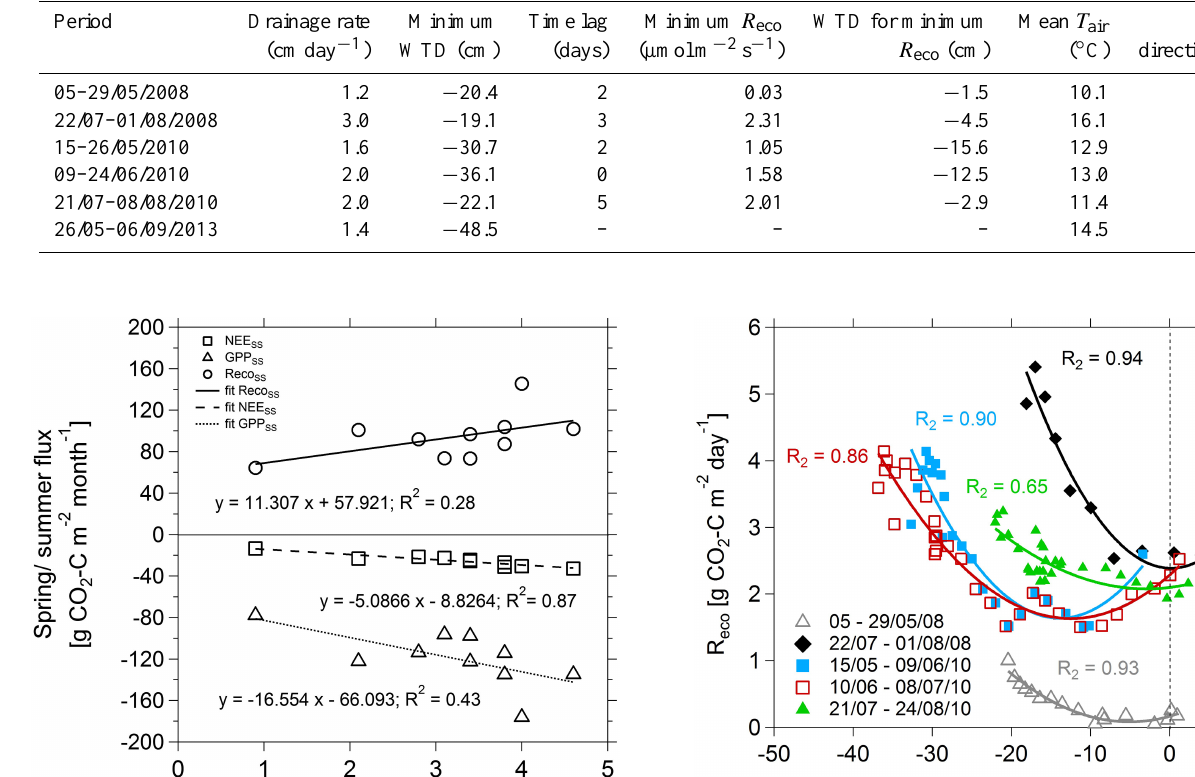
Table 2. Water table drainage rates and minimum water table depths (WTD) observed during the summer dry spells of 2008, 2010 and 2013. The time lag is the number of days elapsed between the start of the dry period and the onset of a response from the ecosystem respiration ( R eco ); the time lag was determined by optimising the polynomial fit between R eco and WTD. The minimum value of R eco for each dry spell and the water table depth corresponding to each minimum value of R eco were calculated using a second degree polynomial regression function between R eco and WTD. No parabolic relationship was observed in 2013 between R eco and WTD; for this reason, time lag, minimum R eco and WTD for minimum R eco could not be calculated.